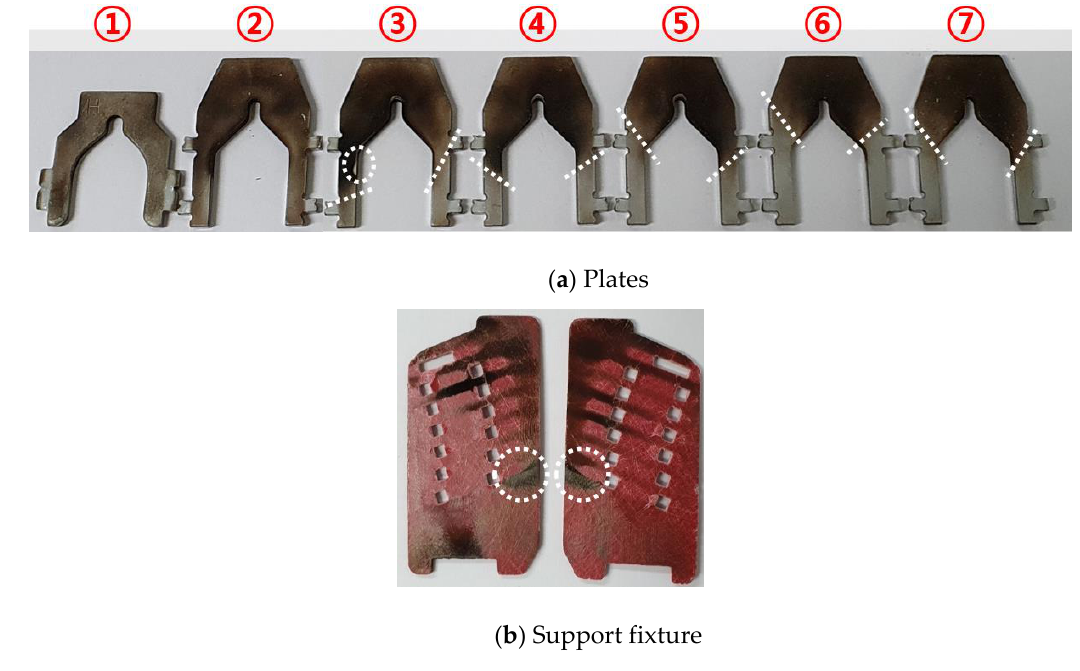
Figure 16. Damaged splitter plate after experimentations.